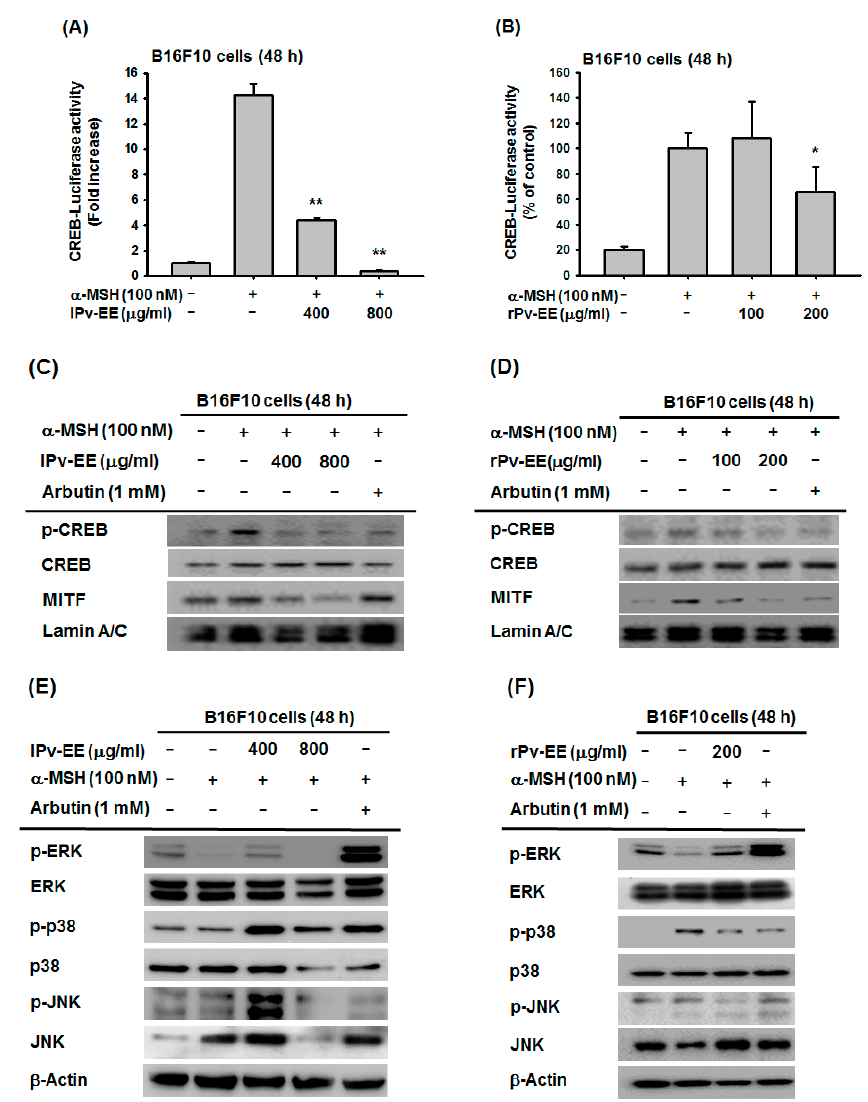
Figure 3. Anti-melanogenic mechanism of lPv-EE and rPv-EE in α -MSH-treated B16F10 cells. ( A , B ) The promoter binding activity of the transcription factor CREB was analyzed using a reporter gene assay. B16F10 cells were transfected with plasmids driving the expression of CREB-Luc (1 μ g/mL) and β -gal (as a transfection control). After 24 h, some cells were treated with 100 nM α -MSH and lPv-EE (400 or 800 μ g/mL) or rPv-EE (100 or 200 μ g/mL) for 24 h. Luciferase activity was measured using a luminometer. ( C–F ) Levels of phosphorylated and total CREB, MITF, ERK, p38, JNK, and β -actin proteins were determined in B16F10 cells using phospho-specific or total antibodies for each protein. ** p < 0.01 compared to the normal group and * p < 0.05 compared to the control group.